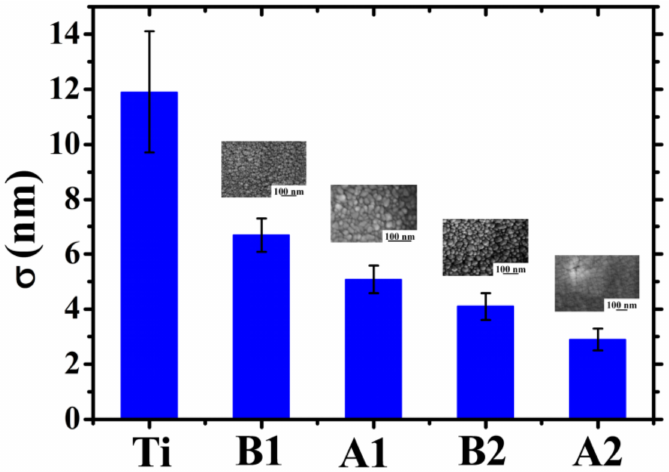
Figure 8. Plot synthesizing the comparison of the roughness σ for the bare Ti surface, of the surface of the thinner (140 nm) Au film deposited, at θ = 48 ◦ , on Ti foil (sample B1), thinner (220 nm) Au film deposited, at θ = 0 ◦ , on Ti foil (sample A1), thicker (230 nm) Au film deposited, at θ = 48 ◦ , on Ti foil (sample B2), thicker (350 nm) Au film deposited, at θ = 0 ◦ , on Ti foil (sample